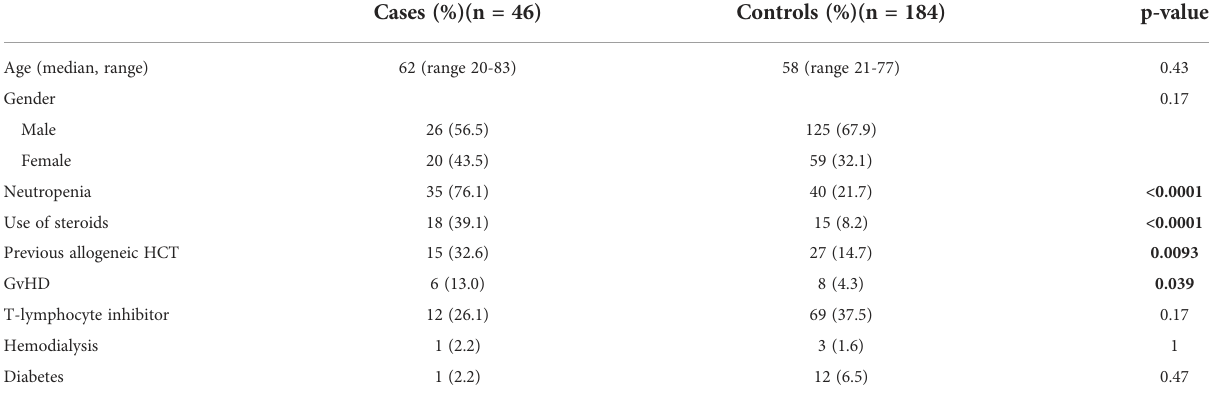
TABLE 1 Characteristics of the hematology patients included in the study